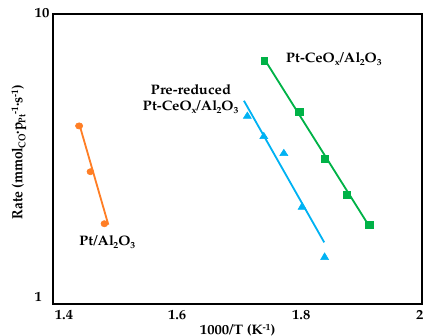
Figure 12. Arrhenius plots used to calculate apparent activation energies for WGS reaction on supported Pt catalysts, adapted from [84], with permission from Elsevier, 2017; P = 1 atm, 16% CO, 32% H 2 , 32% H 2 O, 20%N 2 , GHSV = 75,000 mL·g cat − 1 ·h − 1 .